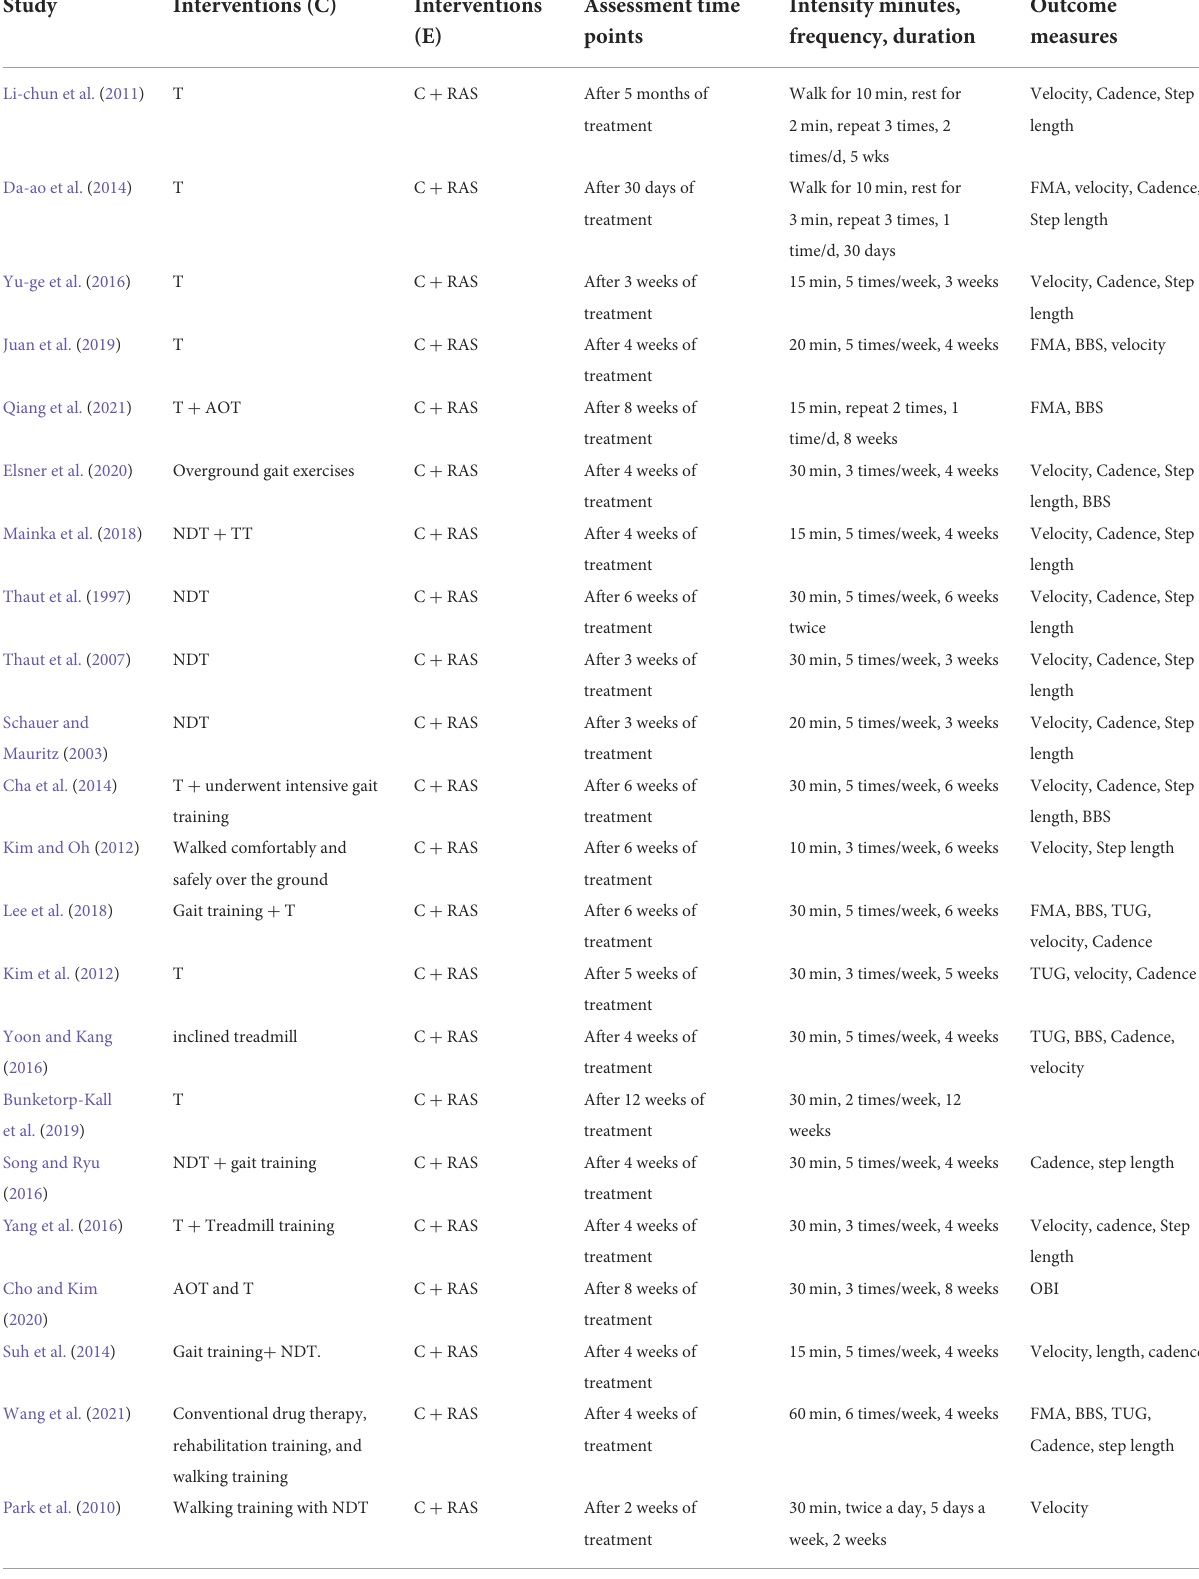
TABLE 3 Characteristics of study design in the included